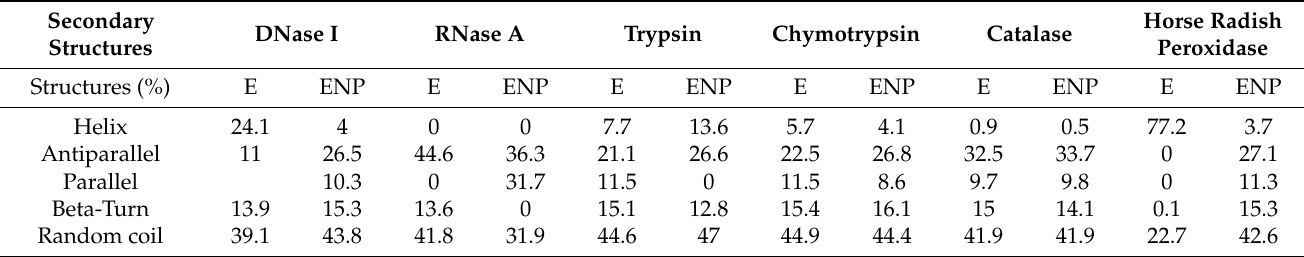
Table 1. Deconvolution analysis of the circular dichroism (CD) spectra of the enzymes in water solutions (E) and nanoparticles